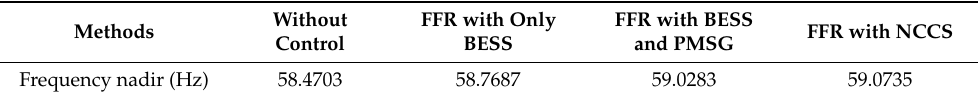
Table 4. Comparison of frequency nadir